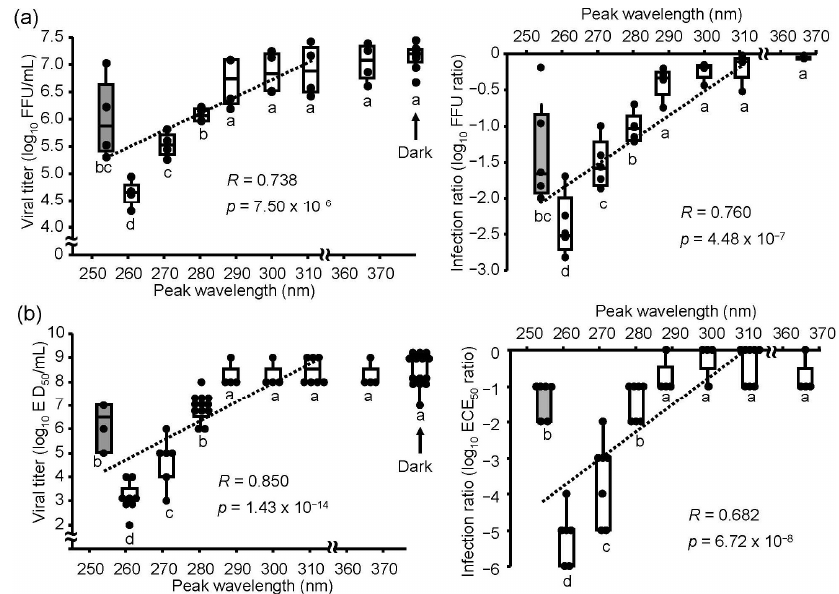
Figure 2. Inactivation effect of the UV-LEDs and LP-UV lamp on the influenza A virus H1N1 subtype. Viral suspensions of the H1N1 subtype (strain A/Puerto Rico/8/1934) were irradiated by different peak wavelength UV-LEDs (empty boxes) and an LP-UV lamp (gray box) at 4.8 mJ/cm 2 and infected into MDCK cells ( a ) or embryonated chicken eggs ( b ). Viral inactivation effects of these irradiations were determined by the difference of viral titers (left panels) and the log 10 focus-forming assay (FFU) ratio and embryo infection dose (EID 50 ) ratio (right panels), as described in the Materials and Methods section. Each box plot shows the median (dark bar), values to the 1.5 interquartile ranges (whiskers), and 25 to 75 percentile ranges (box) ( n = 4–8, n = number of independent replicates). The dashed line shows the relationship between peak wavelengths and infection ratios. Di ff erent letters of the alphabet indicate a statistical di ff erence ( p < 0.05) compared with each other.